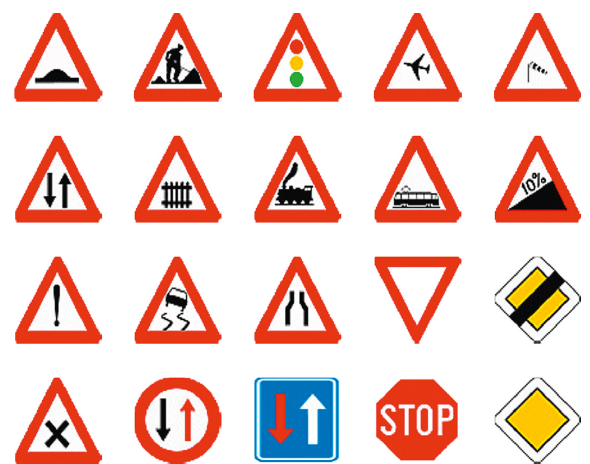
Figure 4: Sample of the dataset images.